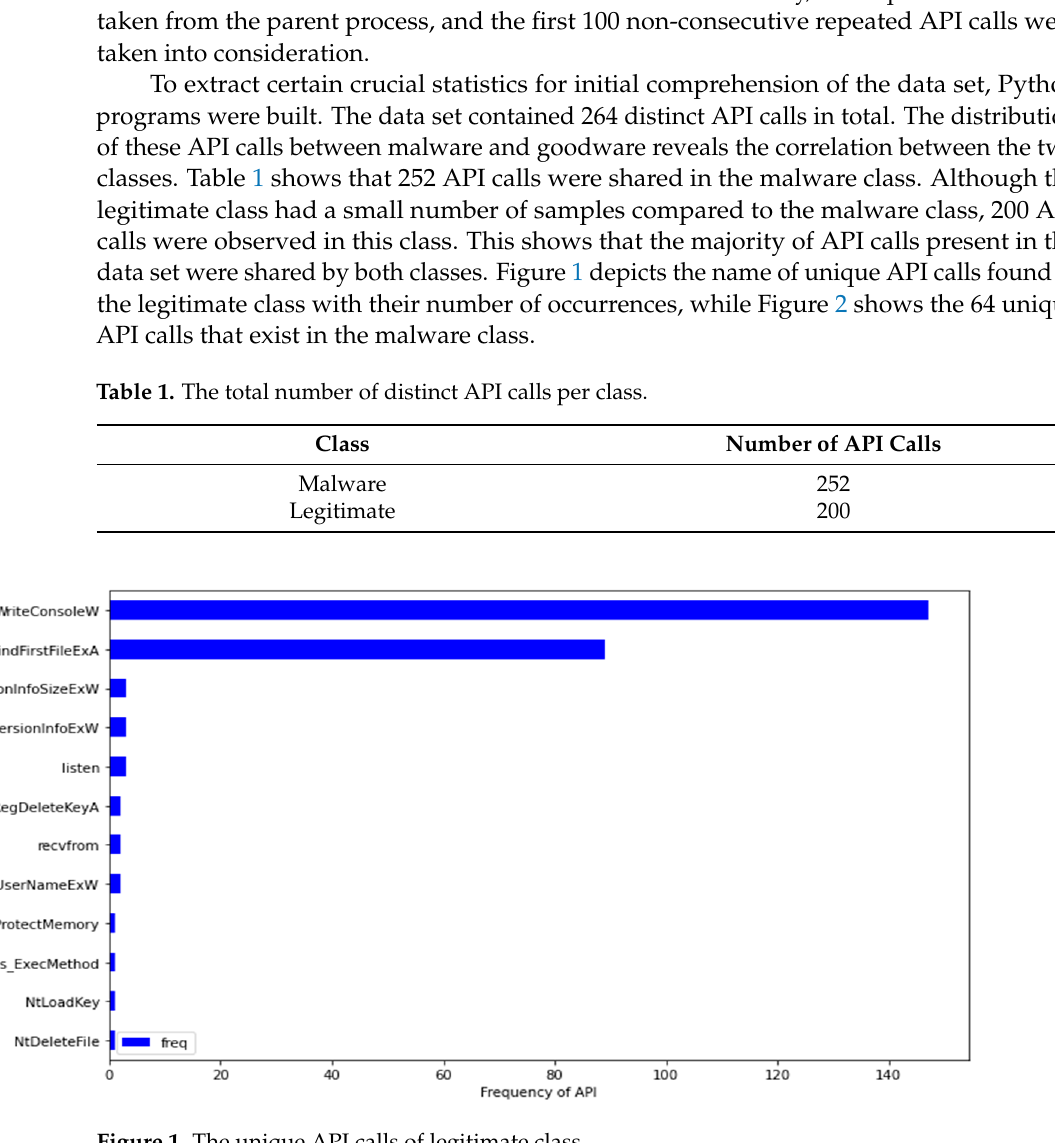
Figure 2. The unique API calls of malware class. Examining the most frequently used API calls of each class may uncover the thinking trend of malware creators. Figure 3 shows the top 30 most used API calls for each class. The interesting observation about Figure 3 is that both classes share 23 API calls. Table 2 lists the unique API calls for each class. ( a ) ( b ) Figure 3. The top 30 API requests that are used the most: ( a ) Malware class; ( b ) legitimate class.